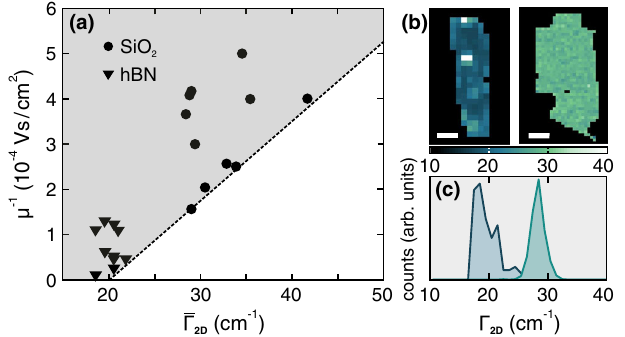
FIG. 5. (a) Correlation of the inverse mobility and the average full width at half maximum of the Raman 2D peak Γ 2 for a D number of graphene flakes on different substrates. (b) Raman maps of two graphene flakes resting on two different substrates (left, hBN; right, SiO 2 ) highlighting the different values of the spatially resolved Γ 2 (same color scale). The white scale bars are D 2 μ m. (c) Histograms of Γ 2 D for the two examples shown in (b). These histograms are used to extract the data points illustrated in